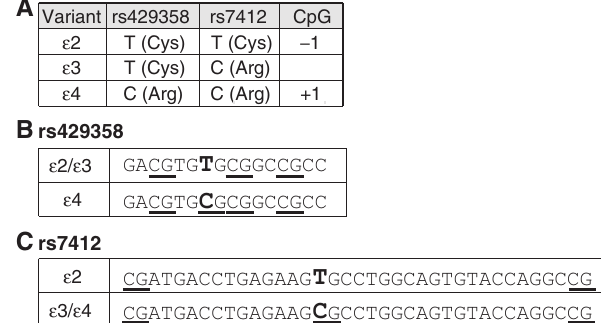
Figure 2: Sequence context of the two CpG SNPs that determine APOE ’ s ε 2/ ε 3/ ε 4 alleles. (A) Haplotype composition of the two CpG SNPs: rs429358 and rs7412. Their encoded amino acids are shown in the parentheses. (B) The C nucleotide of rs429358 introduces an extra CpG into a 12-bp CpG-enriched region. (C) The T nucleotide of rs7412 eliminates a CpG and open up a 33-bp CpG-depleted region of the CGI. CpG dinucleotides are underlined. SNPs are in bold type.